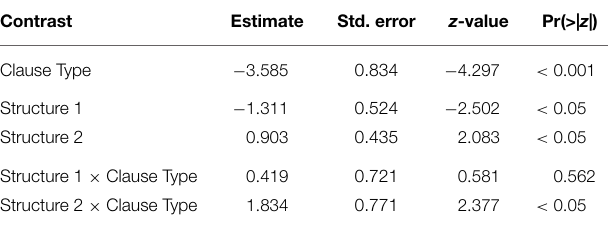
TABLE 2 | Mixed-effects model for the judgment results of Experiment